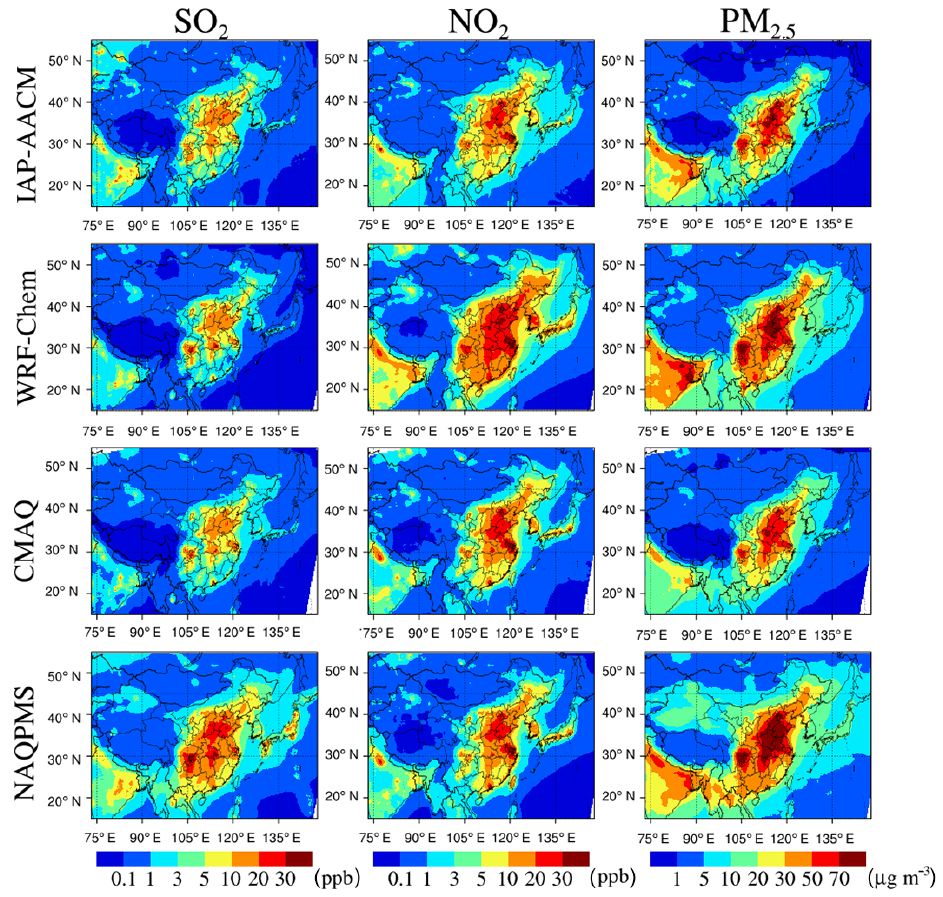
Figure 12. Annual surface distributions from the nested IAP-AACM compared with regional models from MICS-Asia. Each row from top to bottom represents IAP-AACM, WRF-Chem, CMAQ, and NAQPMS respectively. The left column is SO 2 (ppb), the middle column is NO 2 (ppb), and the right column is PM 2 . 5 (µgm − 3